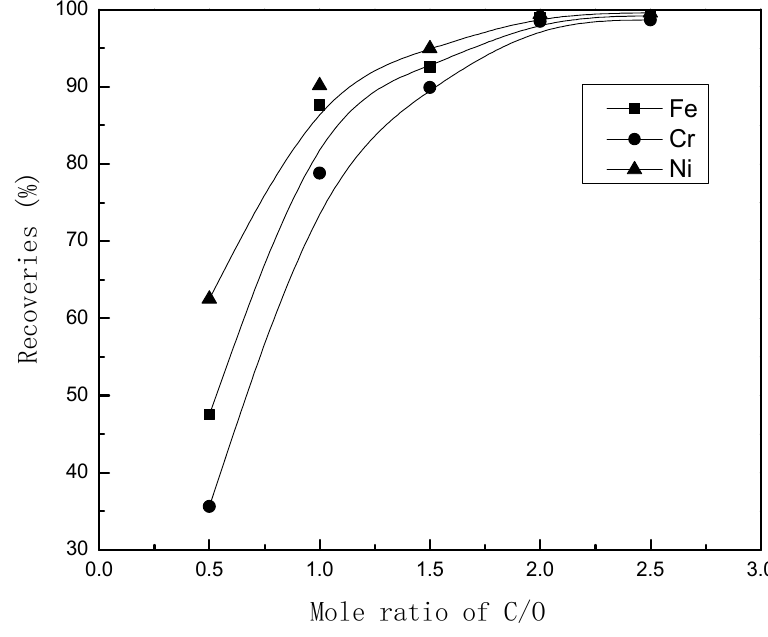
Figure 6. Effect of C/O mole ratio on metals recoveries.